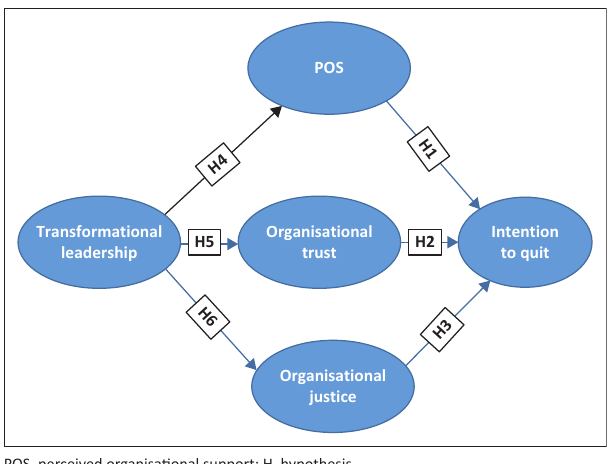
FIG URE 1: Theoretical model of the effect of transformational leadership on intention to quit through perceived organisational support, organisational justice and organisational